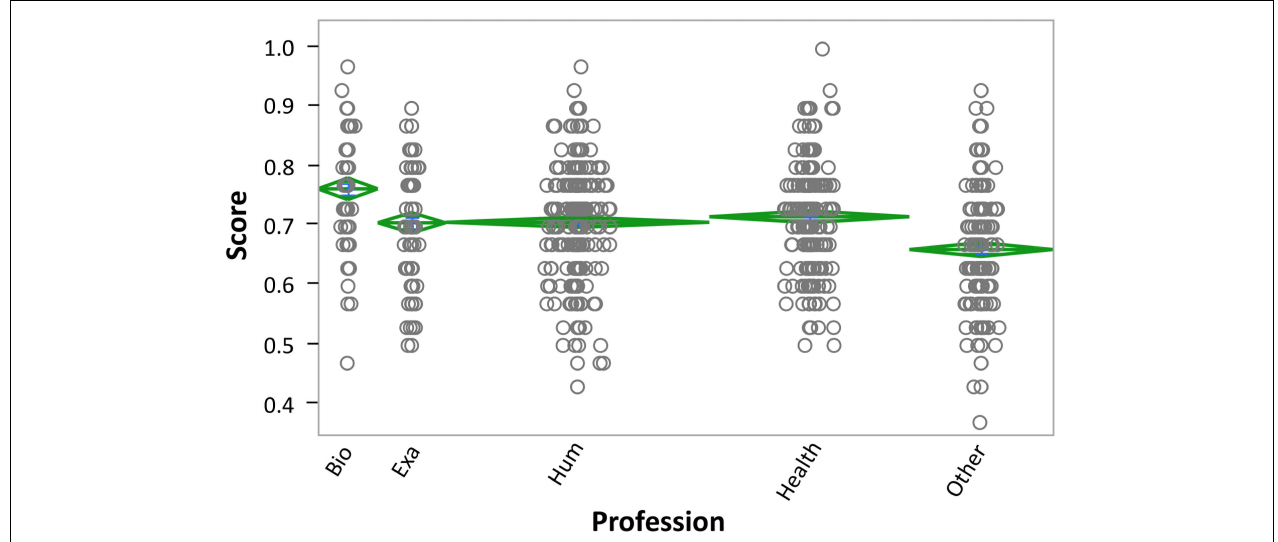
FIGURE 4 | Profession × overall score. Individuals reported studying or working in the areas of Biological Sciences (Bio), Exact sciences (Exa), Humanities (Hum), Health, or Other (other, retired, or not working). Data are shown in mean diamond graphs, where the width of the diamond is directly proportional to the sample size, and the height corresponds to the variance. No intersection between diamonds implies rejection of the null hypothesis for an α error of 5%. The circle markers represent each participant’s